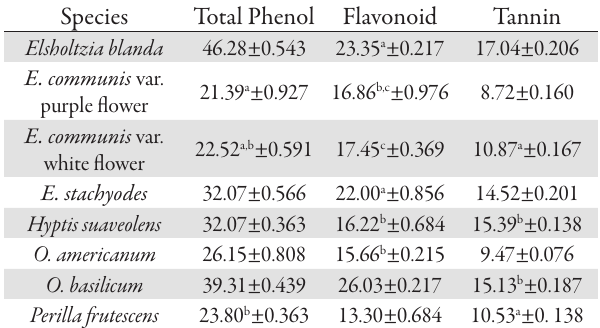
Tab. 2. Polyphenolic Contents (mg/g DW (Dry